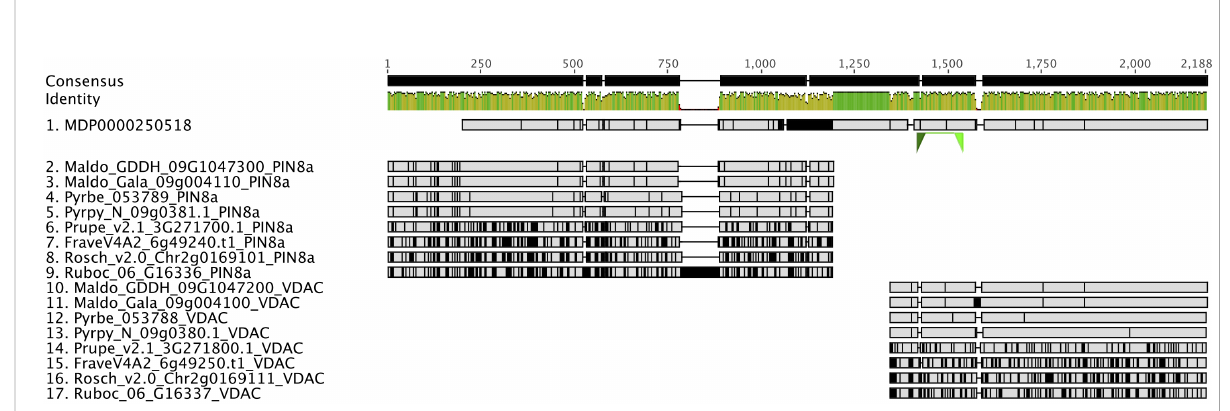
FIGURE 7 Identi fi cation of an incorrect auxin transporter gene model, MdPIN8a , in Malus domestica genome annotation version 1. Nucleotide sequence alignment of putative PIN8a and VDAC genes from 9 Rosaceae genomes were shown here. MDP0000250518 (sequence 1) gene model is a combination of two genes: The 5 ’ end of MDP0000250518 shares high sequence similarity with the PIN8a gene from other Rosaceae species (sequence 2 to 9), while its 3 ’ end shows evidence of homology to a neighboring gene, VDAC , in the investigated genomes (sequence 10 to 17). Green triangles below MDP0000250518 show the binding sites of the qRT-PCR primers used in the Song et al., 2016 research. Gray color indicates identical nucleotides compared to the consensus, while black color indicates different nucleotides. Genome abbreviations can be found in Supplemental Table